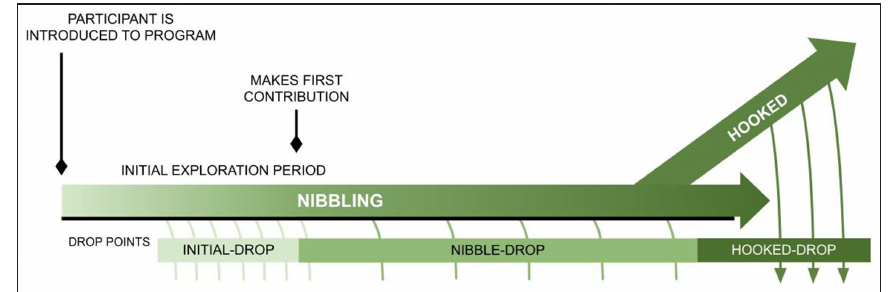
Figure 2 A model showing the possible pathway of a volunteer’s participation in a citizen science program over time, demonstrating how their participation may fall into different categories of our Nibble-and-Drop Framework, depending on how they contribute and if and when they choose to stop